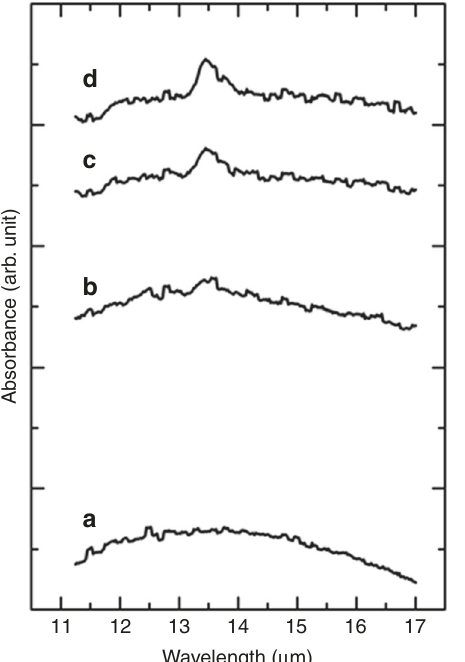
Fig. 2 Absorption spectra of nascent Al 2 O 3 nanoparticles. These spectra have been accumulated at ( a ) 97.6 – 100.2, ( b ) 103.0 – 104.5, and ( c )